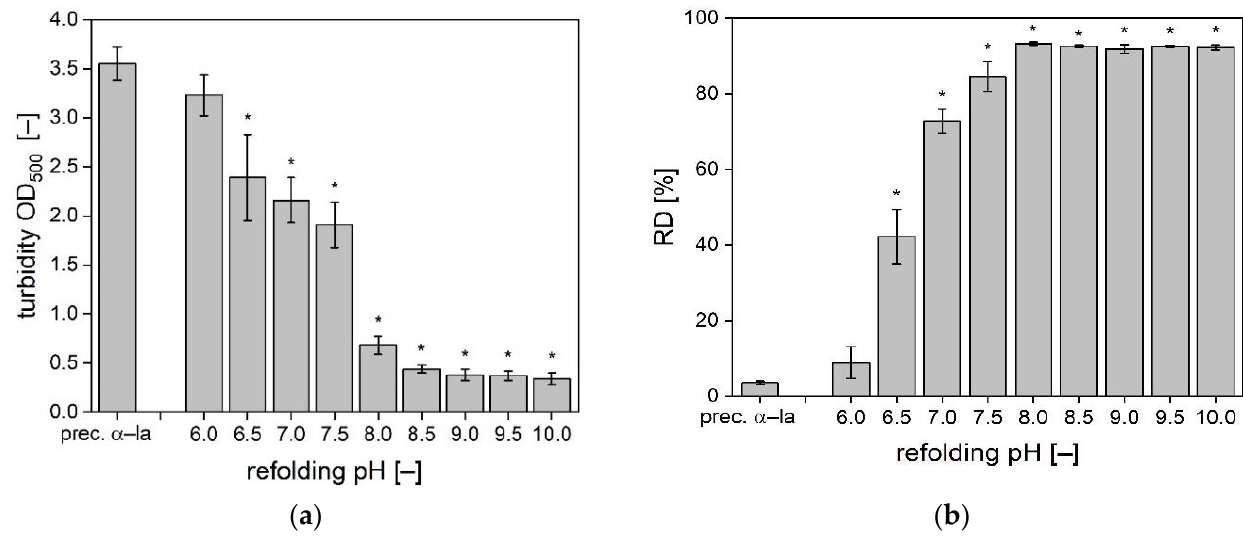
Figure 1. ( a ) OD 550 as measure for turbidity of the precipitated and washed α -la and of resolubilized α -la samples after pH adjustment and CaCl 2 addition. Data are given as mean ± SD, n = 3. * Significantly different than precipitated α -la ( p < 0.05). ( b ) Resolubilization degree RD of the precipitated and washed α -la and of resolubilized α -la samples after pH adjustment and CaCl 2 addition. Data are given as mean ± SD, n = 2. * Significantly different than precipitated α -la ( p < 0.05).